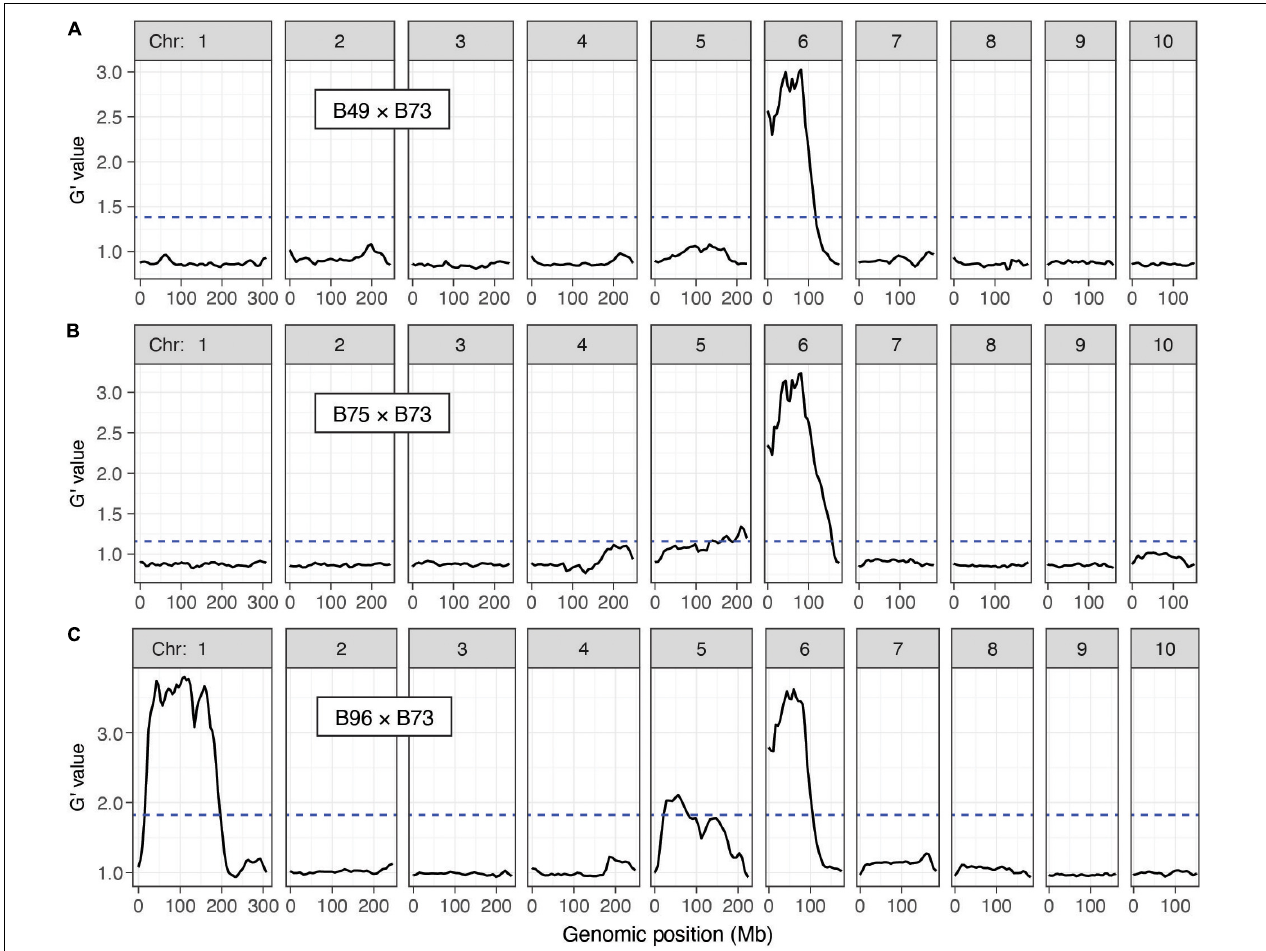
FIGURE 4 | Resistance QTL to T. urticae as identified by BSA genetic mapping in F2 maize populations. Shown are plots of G’ obtained from contrasting pools of T. urticae strain W-GR resistant and sensitive plants from crosses of resistant maize lines B49, B75 and B96 to susceptible line B73 ( A–C , respectively; chromosomes 1–10 are as indicated, left to right). Deflections in G’ values exceeding a genome-wide false discovery rate of 0.01 (dashed lines) identify QTL. Extent of resistance was based on leaf damage scores on the 4th leaves, and for each cross the panels represent the combined analysis of two experimental replicates (combined, 100 plants in each of the resistant and susceptible pools of phenotypic extremes; see section “Materials and Methods”). Respective individual analyses for each of the two replicates by cross, B49 × B73, B75 × B73, and B96 × B73, are given in Supplementary Figures 2 – 4 , respectively. The plots shown were modified from the output of QTLseqr (see section “Materials and